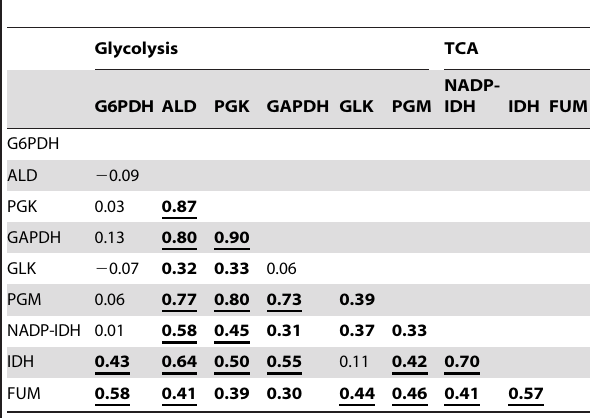
Table 2. Correlations between activities of nine CCM enzymes.